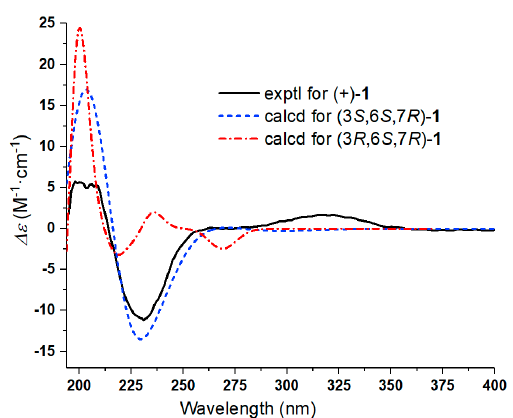
Figure 3. Comparison of the experimental ECD spectrum of (+)- 1 with calculated ECD spectra for (3 S ,6 S ,7 R )- 1 ( σ = 0.30 eV; shift = − 16 nm) and (3 R ,6 S ,7 R )- 1 ( σ = 0.16 eV; shift = − 38 nm) in MeOH. As a